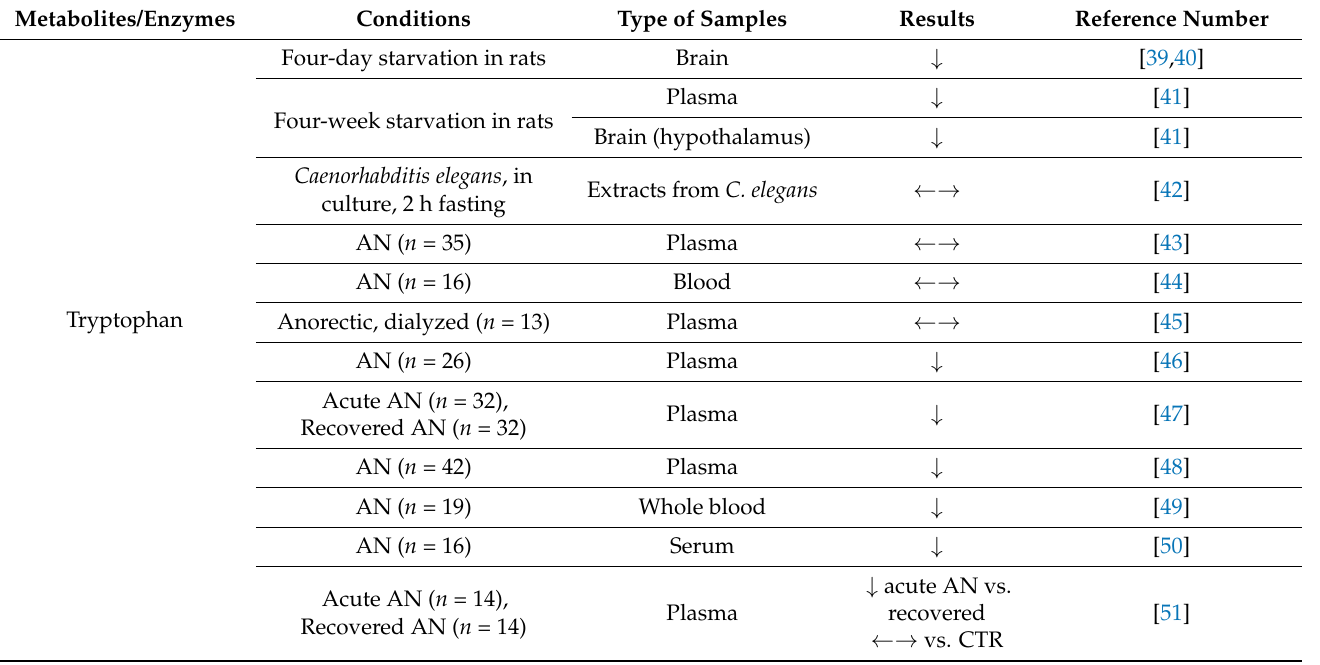
Table 1. Tryptophan, kynurenines, and the kynurenine pathway enzymes in experimental and clinical studies on anorexia